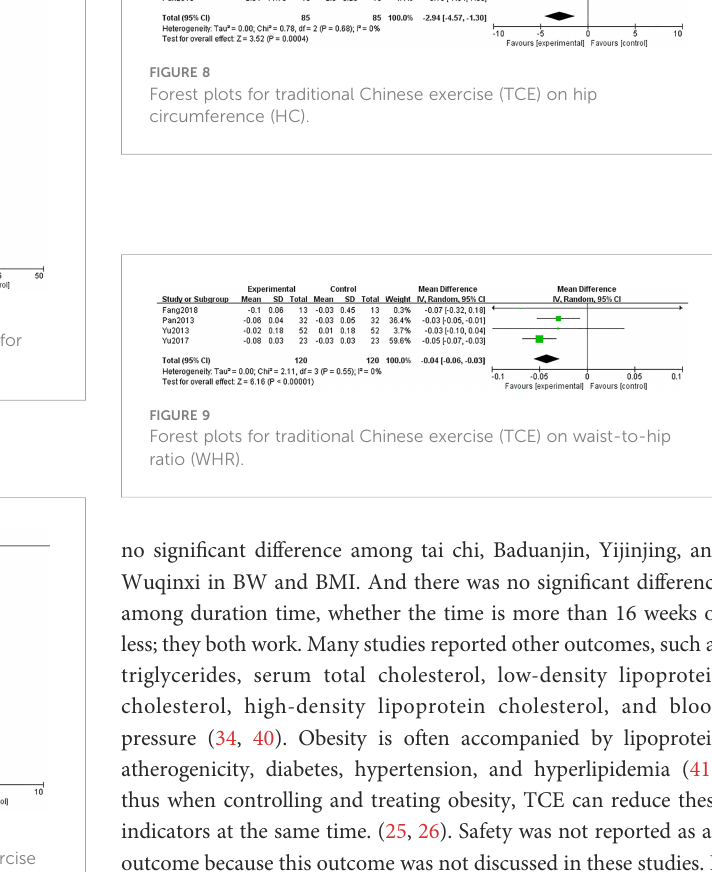
FIGURE 8 Forest plots for traditional Chinese exercise (TCE) on hip circumference